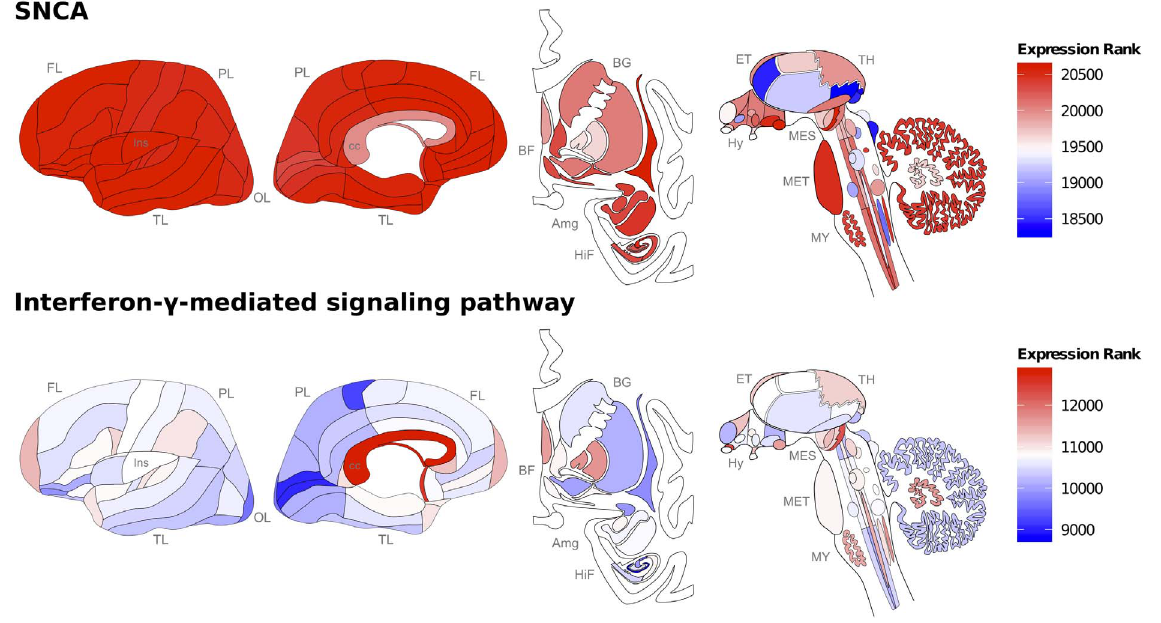
Fig. 1. Brain map showing ranked gene expression of SNCA and IFN- c -mediated signaling pathway genes. Expression ranges from high (red) to low (high), with the two maps showing disjoint ranges. Ranked expression was averaged across donors and subregions. Displayed expression for the interferon pathway gene set is the median across genes. Abbreviations for the brain regions: frontal lobe (FL); parietal lobe (PL); temporal lobe (TL); occipital lobe (OL); basal forebrain (BF); basal ganglia (BG); amygdala (AmG); hippocampal formation (HiF); epithalamus (EP); thalamus (TH); hypothalamus (Hy); mesencephalon (MES); metencephalon (MET) and myelencephalon